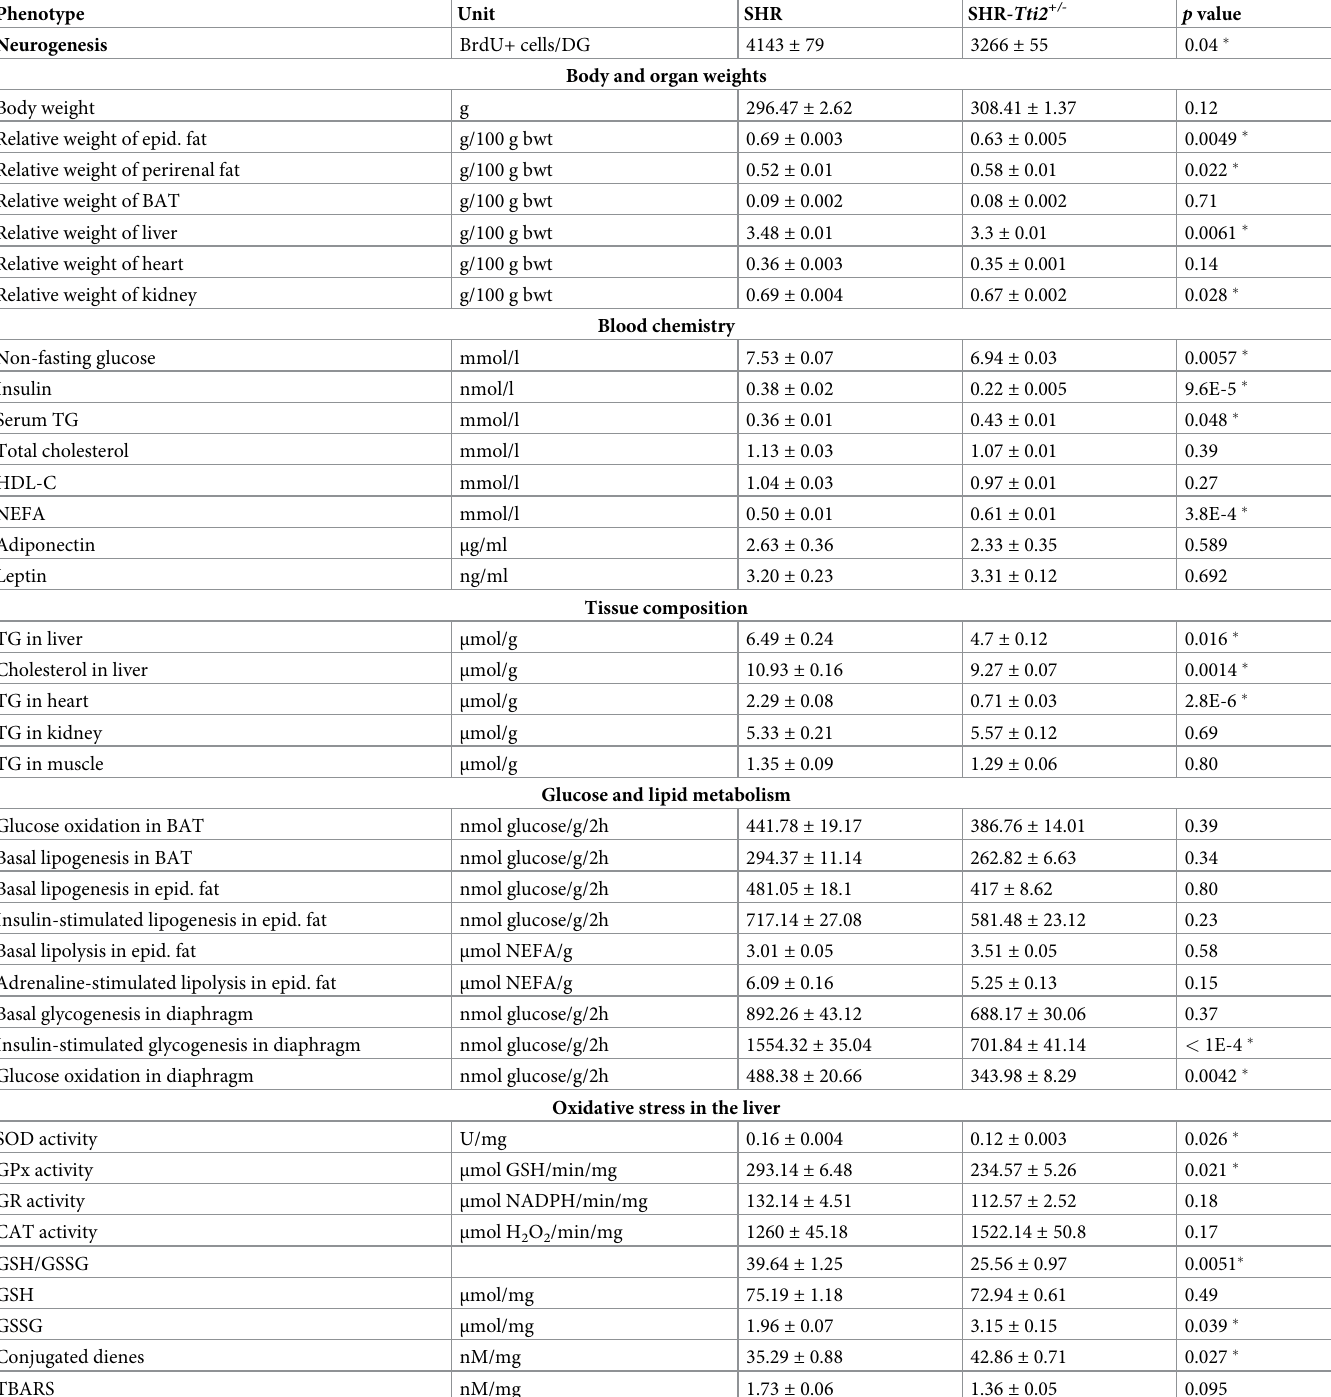
Table 2. Statistical comparison of neurogenesis and metabolic traits between SHR- Tti2 +/- rats and SHR wild type